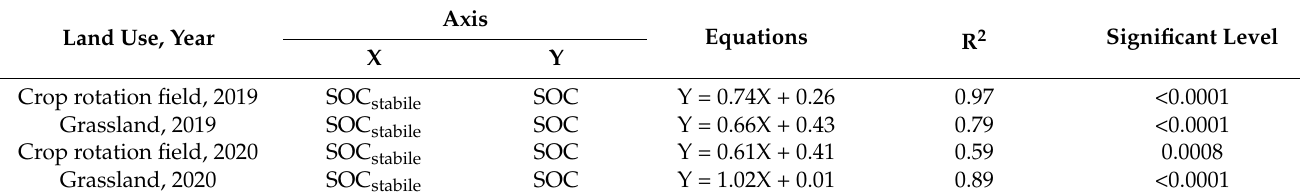
Table 3. Regression equations among stratification ratios for 0–10:10–20 cm of stabile soil